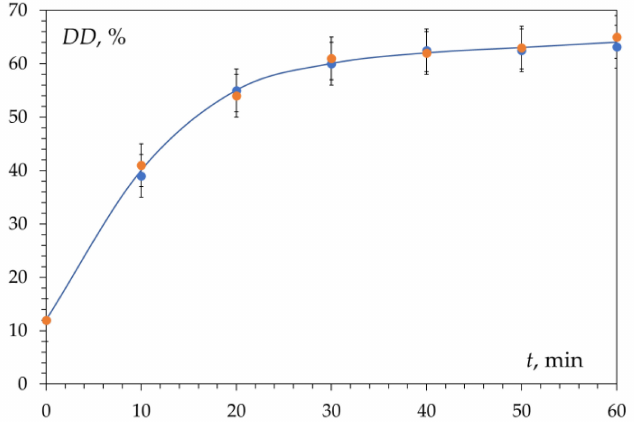
Figure 5. Kinetic curves of chitin deacetylation in 50% NaOH ( • ) and in 50% NaOH with the addition of 5% CH3COONa ( • ). Original